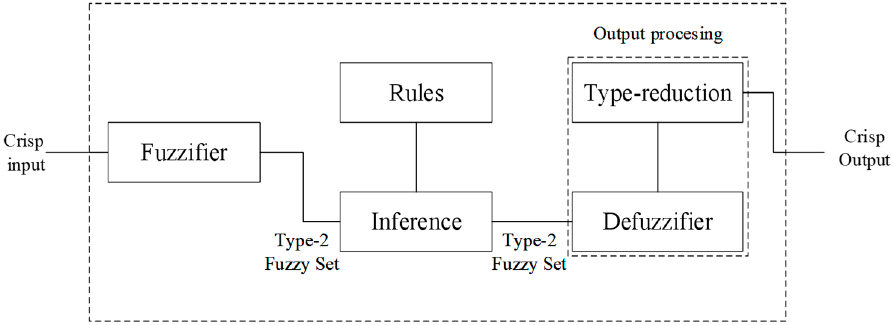
Figure 1. Mamdani interval type-2 fuzzy logic system.